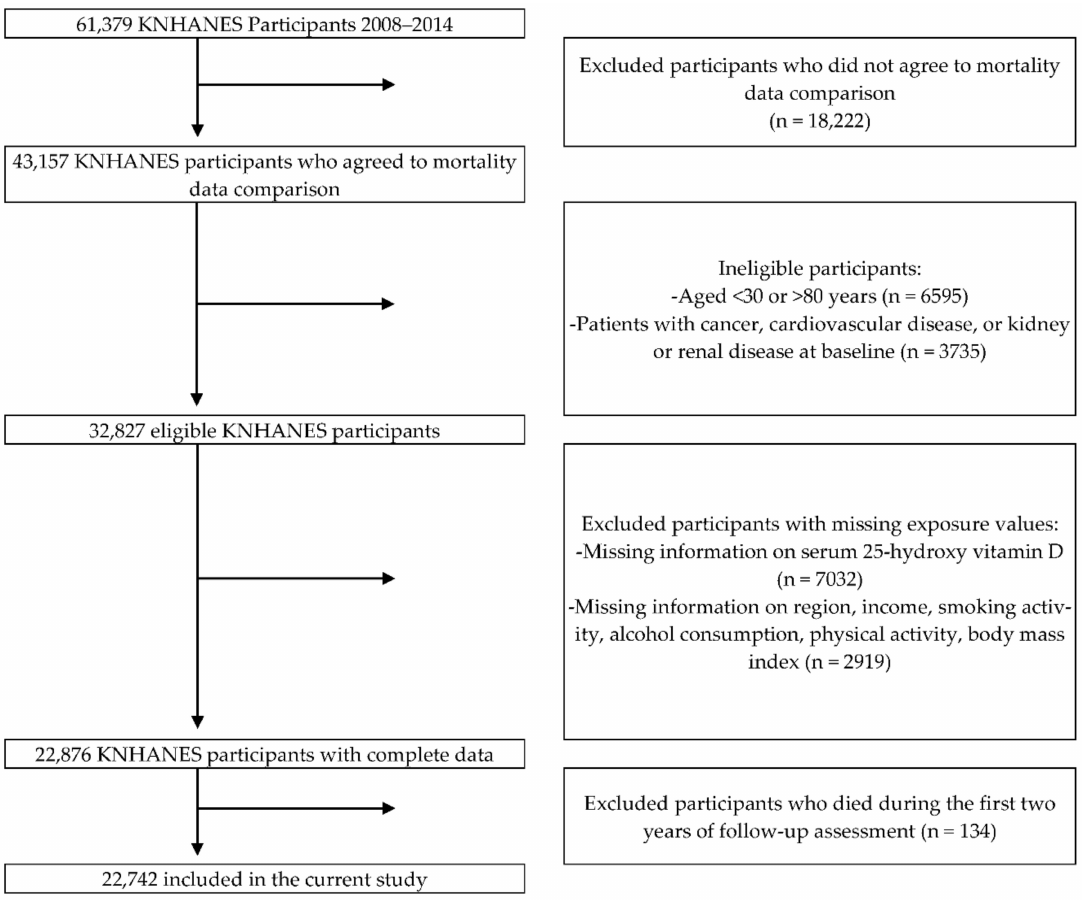
Figure 1. Study participant flow